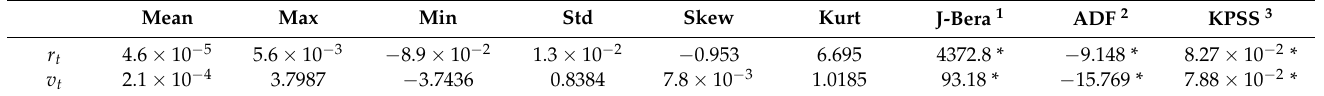
Figure 4. The graph of SSECI volatility increments from 2014 to 2020. Table 1. Descriptive statistics for log return and volatility increments of SSECI.